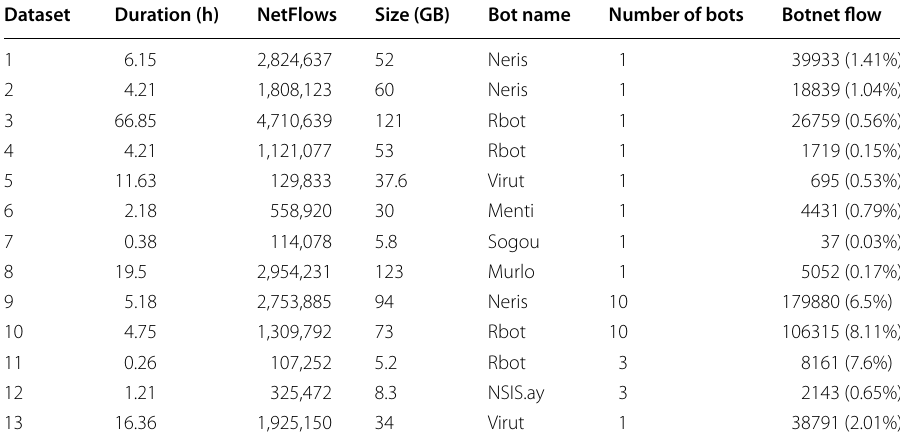
Table 1 Amount of data on each botnet scenario [55] Dataset